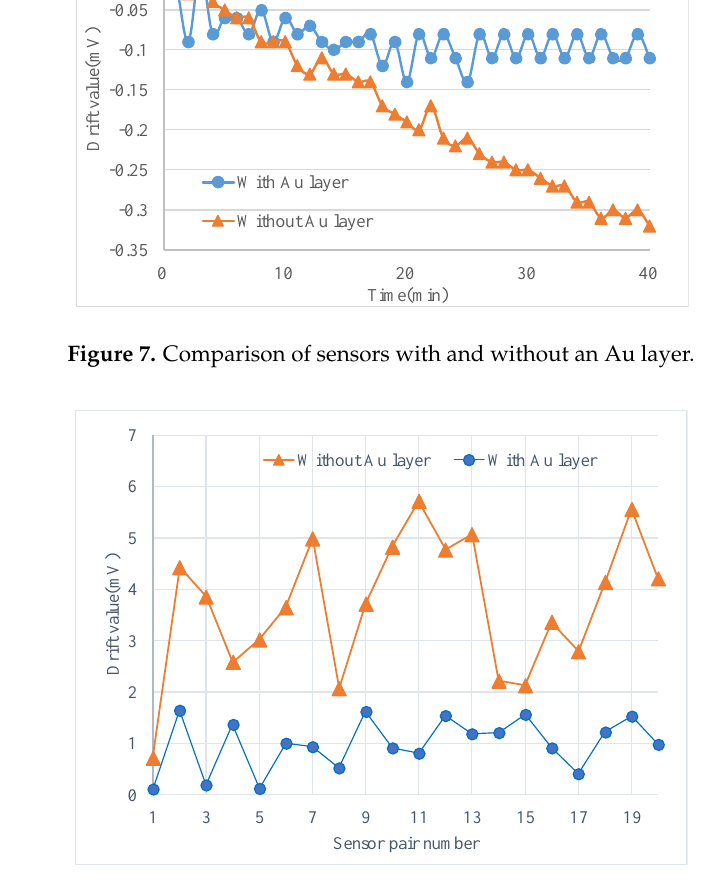
Figure 8. Reduced magnitude of drift for tested sensors with an Au layer as compared with no Au layer.